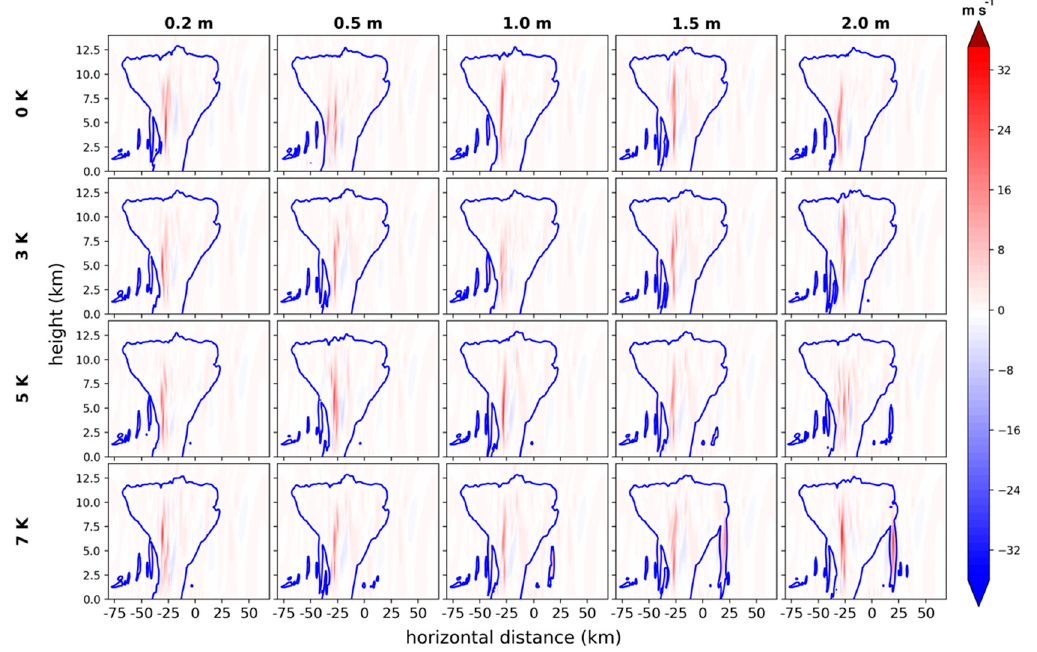
Figure 5. Vertical velocity (colored) at t = 130 min in each simulation. The blue contour represents a hydrometeor mixing ratio of 0.02 g kg − 1 .